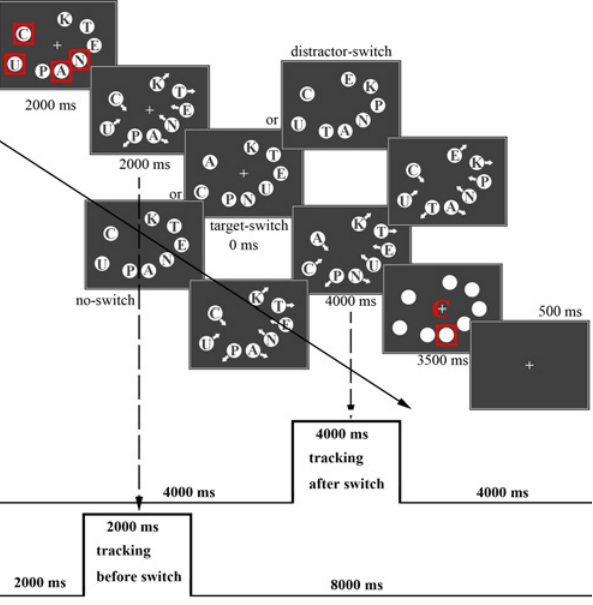
Fig 2. Sample illustrations of a